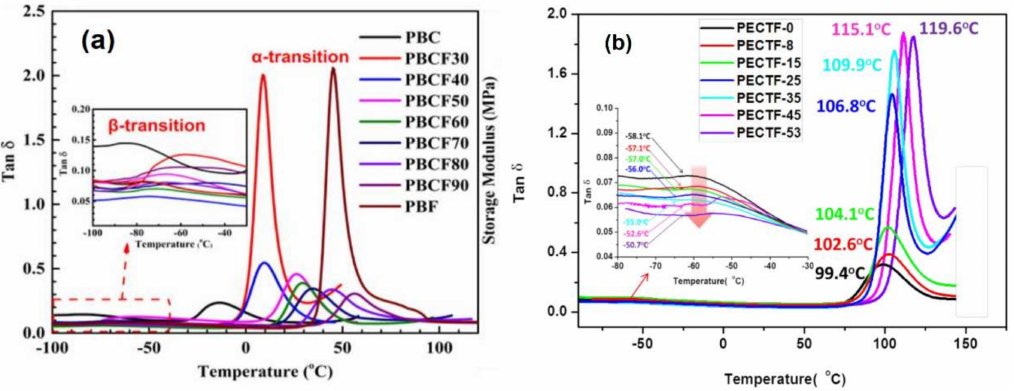
Figure 20. Shifting of α relaxation to higher temperatures with increasing “rigid” composition in ( a ) PBF- co -PBC [84] and ( b ) PEF- co -PCBDOF- co -PCHDMF copolymers